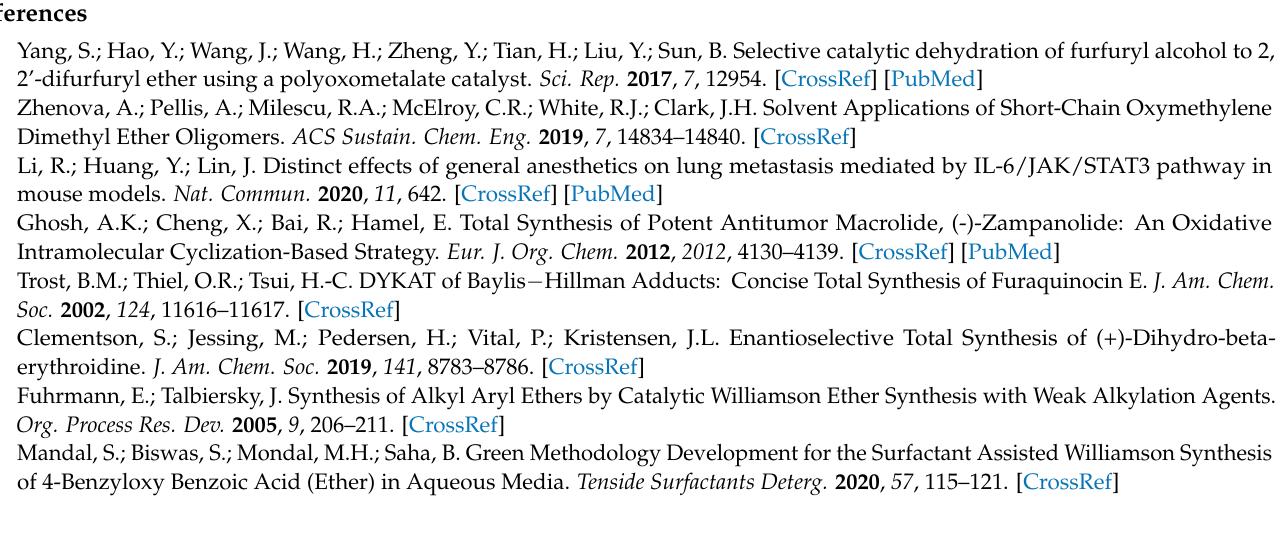
of cinnamaldehyde and n-butanol at 120 ◦ C under 0.1 MPa H2 pressure; (b) GC-MS spectra and its fragmentation pattern of unsaturated ether. Figure S8: (a) GC conversion of the unsaturated ether from the reaction of 1 mmol of cinnamaldehyde and sec-butanol at 120 ◦ C under 0.1 MPa H2 pressure; (b) GC-MS spectra and its fragmentation pattern of unsaturated ether. Figure S9: (a) GC conversion of the unsaturated ether from the reaction of 1 mmol of cinnamaldehyde and n-pentanol at 120 ◦ C under 0.1 MPa H2 pressure; (b) GC-MS spectra and its fragmentation pattern of unsaturated ether. Figure S10: (a) GC conversion of the unsaturated ether from the reaction of 1 mmol of cinnamalde- hyde and 2-pentanol at 120 ◦ C under 0.1 MPa H2 pressure; (b) GC-MS spectra and its fragmentation pattern of unsaturated ether. Figure S11: (a) GC conversion of the unsaturated ether from the reaction of 1 mmol of citral and methanol at 120 ◦ C under 0.1 MPa H2 pressure; (b) GC-MS spectra and its fragmentation pattern of unsaturated ether. Figure S12: (a) GC conversion of the unsaturated ether from the reaction of 1 mmol of citral and ethanol at 120 ◦ C under 0.1 MPa H2 pressure; (b) GC-MS spectra and its fragmentation pattern of unsaturated ether. Figure S13: (a) GC conversion of the unsaturated ether from the reaction of 1 mmol of citral and n-propanol at 120 ◦ C under 0.1 MPa H2 pressure; (b) GC-MS spectra and its fragmentation pattern of unsaturated ether. Figure S14: (a) GC conversion of the unsaturated ether from the reaction of 1 mmol of citral and isopropyl alcohol at 120 ◦ C under 0.1 MPa H2 pressure; (b) GC-MS spectra and its fragmentation pattern of unsaturated ether. Figure S15: (a) GC conversion of the unsaturated ether from the reaction of 1 mmol of citral and n-butanol at 120 ◦ C under 0.1 MPa H2 pressure; (b) GC-MS spectra and its fragmentation pattern of unsaturated ether. Figure S16: (a) GC conversion of the unsaturated ether from the reaction of 1 mmol of citral and sec-butanol at 120 ◦ C under 0.1 MPa H2 pressure; (b) GC-MS spectra and its fragmentation pattern of unsaturated ether. Figure S17: (a) GC conversion of the unsaturated ether from the reaction of 1 mmol of citral and n-pentanol at 120 ◦ C under 0.1 MPa H2 pressure; (b) GC-MS spectra and its fragmentation pattern of unsaturated ether. Figure S18: (a) GC conversion of the unsaturated ether from the reaction of 1 mmol of citral and 2-pentanol at 120 ◦ C under 0.1 MPa H2 pressure; (b) GC-MS spectra and its fragmentation pattern of unsaturated